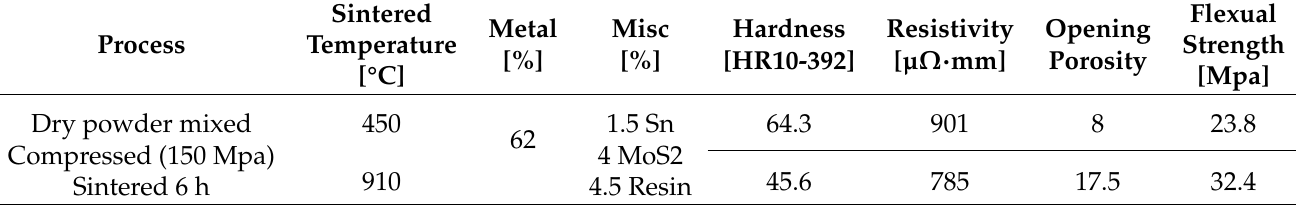
Table 3. Main characteristics of materials used by cited